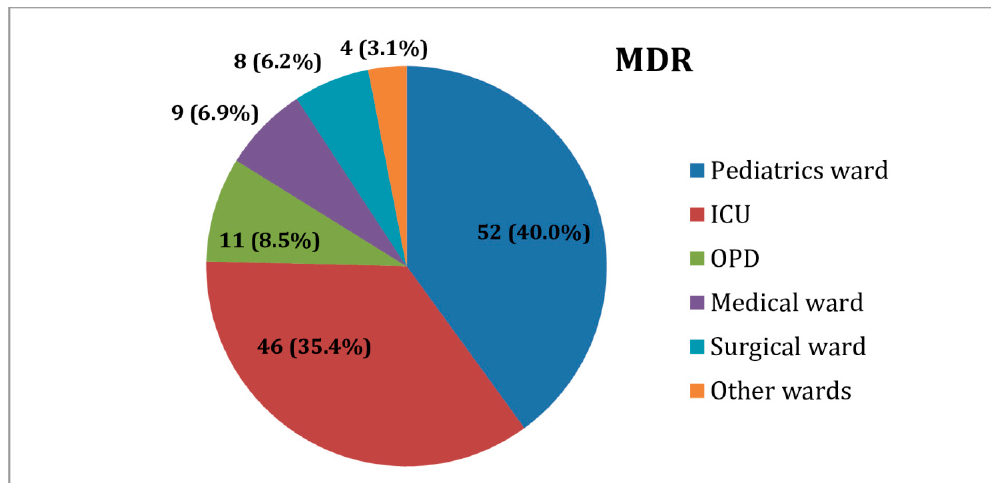
Figure 2. Distribution of MDR K. pneumoniae isolates among inpatients and outpatients. ICUs: Intensive care units; other wards: emergency (2) and orthopedics (2) OPD: outpatient department.